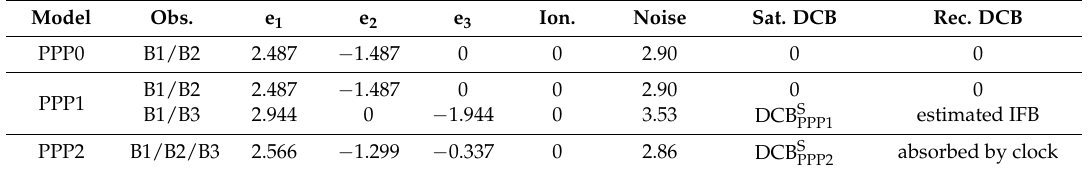
Table 1. Comparisons of dual- and triple-frequency precise point positioning (PPP)